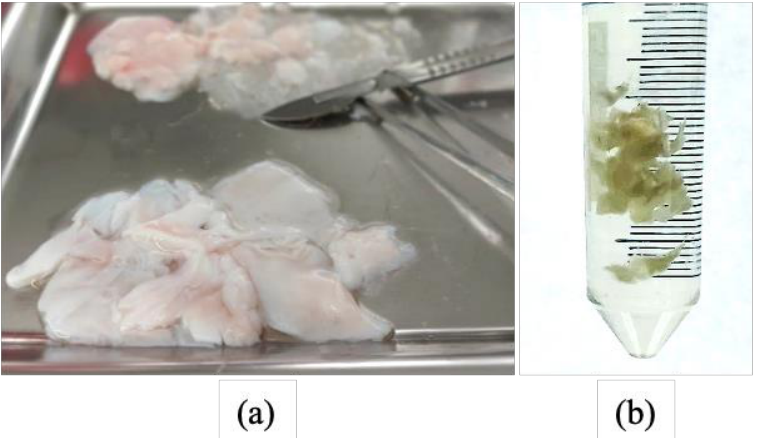
Figure 1. Laboratory arrival and preparation of the fresh tissue to start digestion, isolation, and expansion: ( a ) Tissue collected in the field; ( b ) isolated synovial membrane.